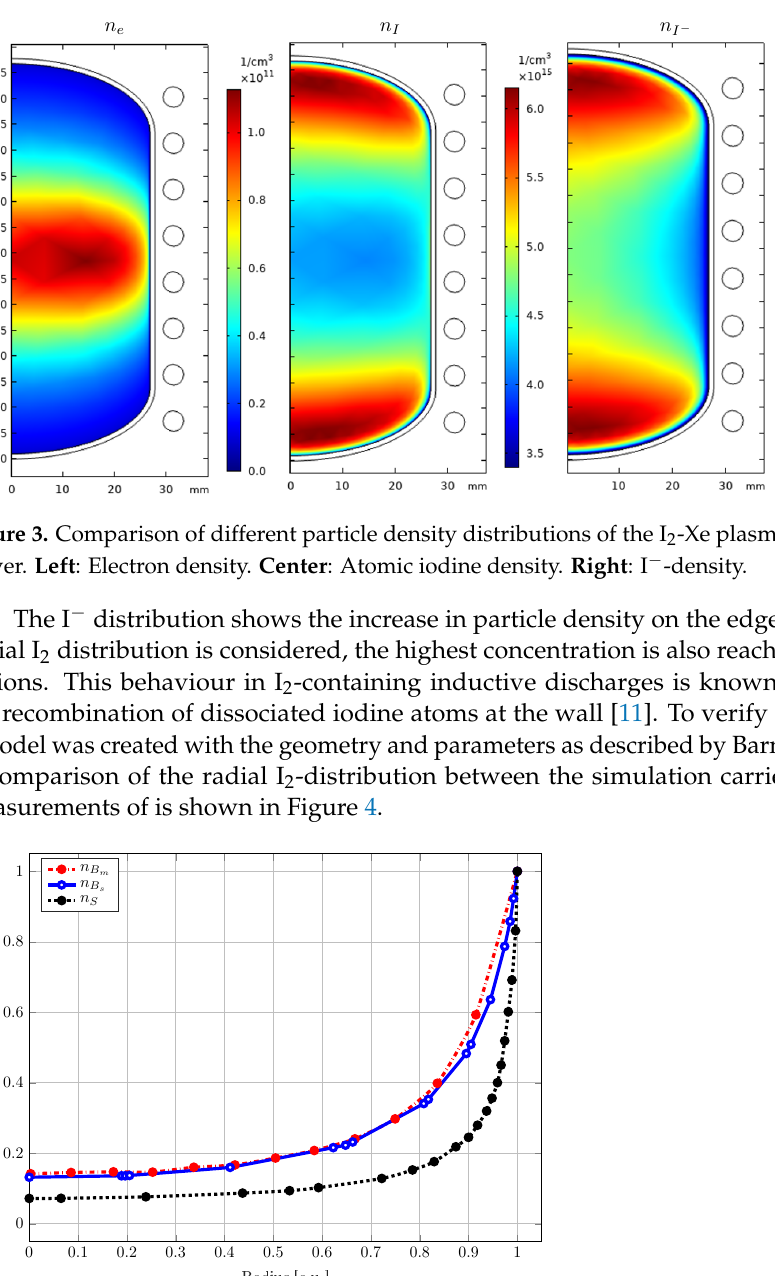
; a simulation using the same m ; and the simulation with the geometry and parameters s